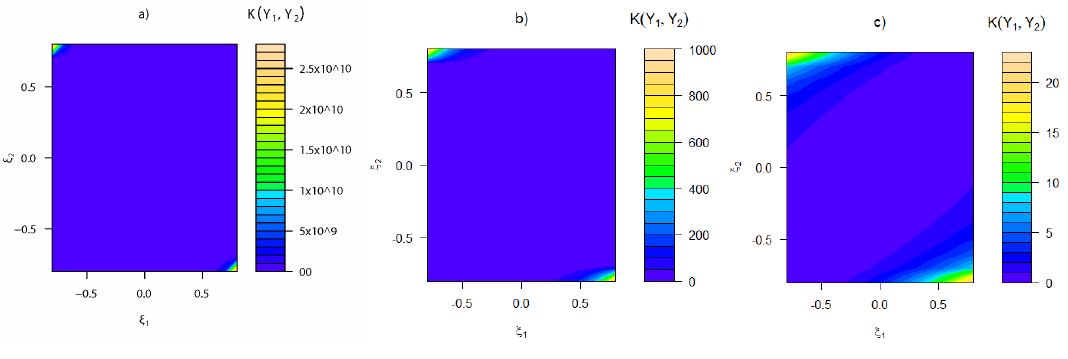
Figure 3. Plots of Kullback–Leibler (KL) divergence between Y 1 ∼ SRG ( 0, σ 1 , η 1 , ε 1 ) and Y 2 ∼ SRG ( 0, σ 2 , η 2 , ε 2 ) for values σ 1 = σ 2 = 1 and ( a ) η 1 = η 2 = 0.25; ( b ) η 1 = η 2 = 3; and ( c ) η 1 = η 2 =